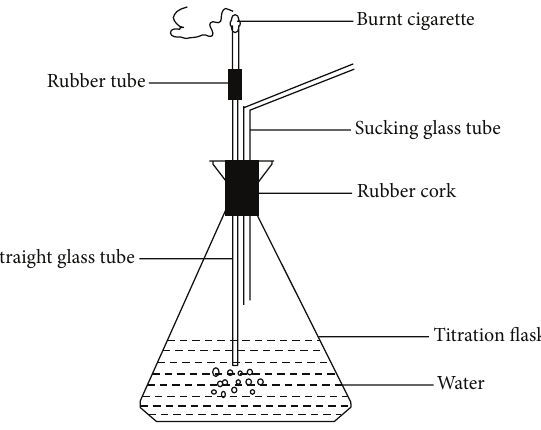
Figure 1: Smoking